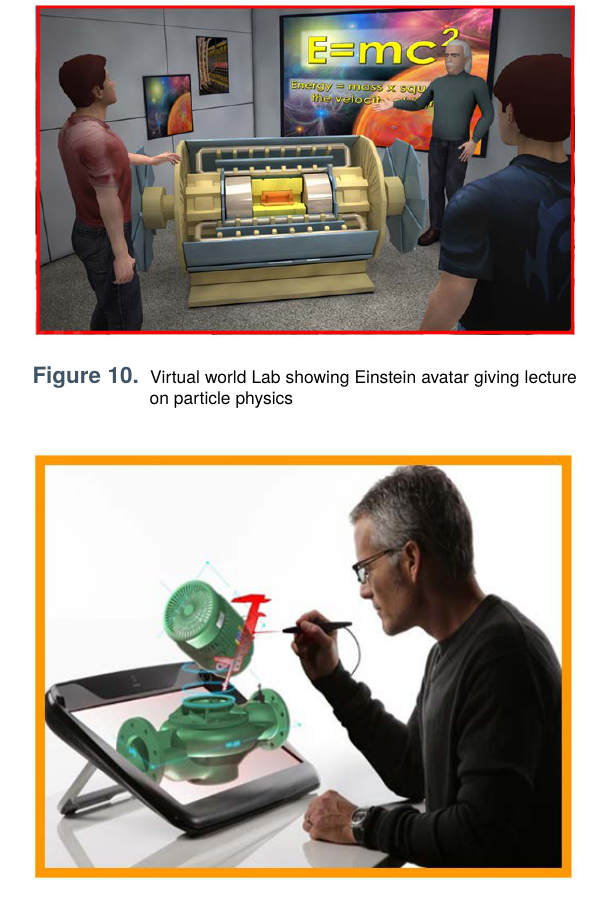
Figure 11. zSpace tablet providing Interaction with 3D Virtual Holo- graphic